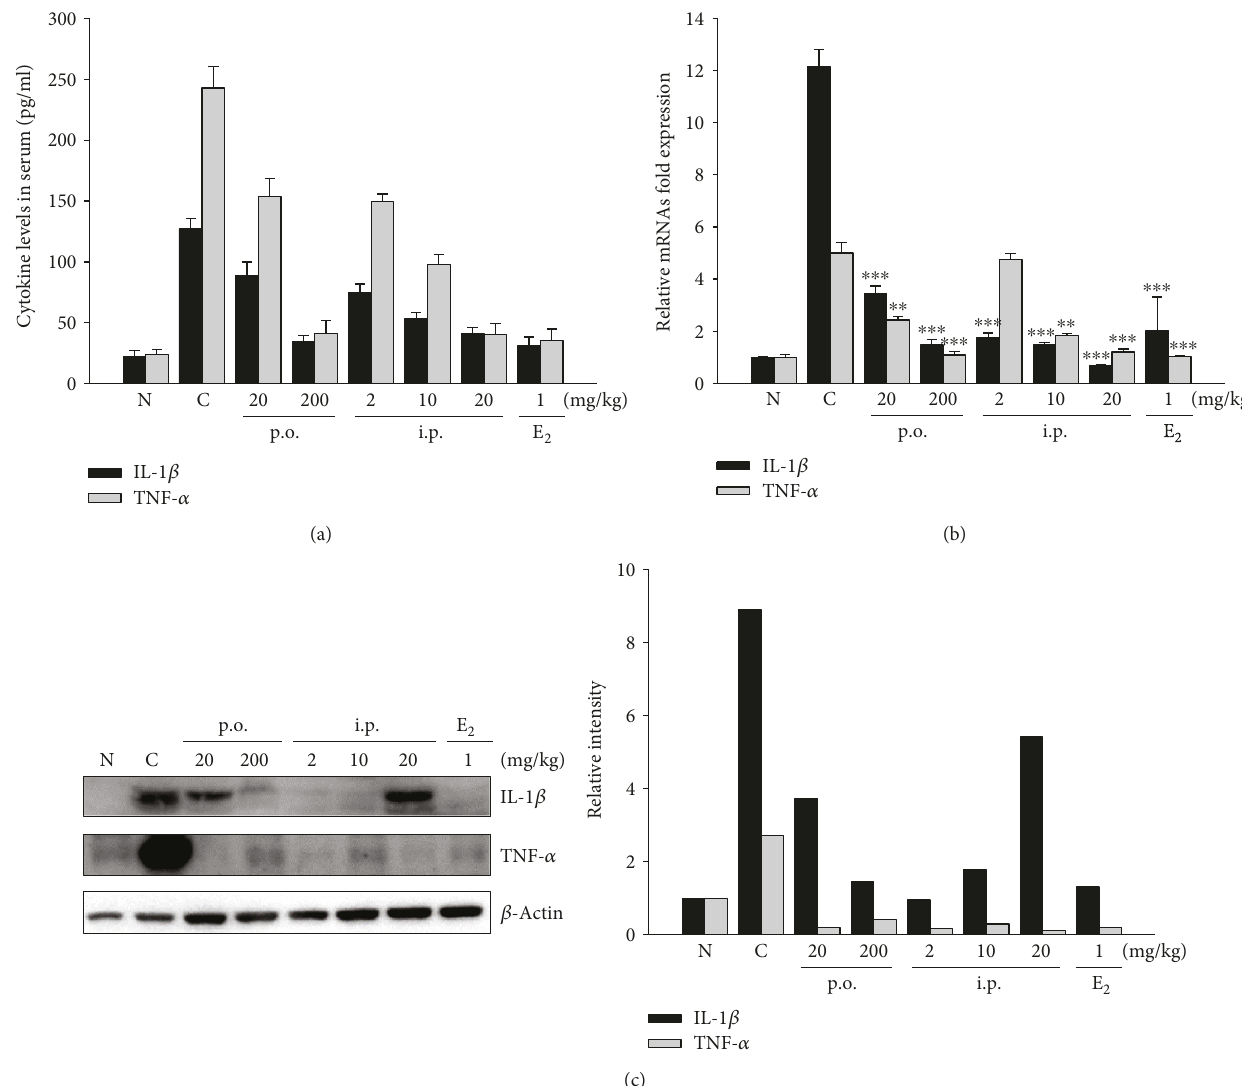
Figure 4: E ff ects of SHINBARO on proin fl ammatory cytokines in the LSS rat model. (a) Serum was collected from rats with LSS and was analyzed for IL-1 β and TNF- α levels using an ELISA kit. The data are expressed as the mean ± SD ( n = 5 ). (b) The mRNA expression of IL-1 β and TNF- α in a spinal cord tissue was determined by real-time RT-PCR. The results were normalized using β -actin as an internal control. The data are expressed as the mean ± SD ( n = 4 ). (c) The expression of proin fl ammatory cytokines in spinal cord tissues was determined by western blot analysis. β -Actin was used as an internal control. Relative intensity of indicated proteins was semiquanti fi ed using the NIH ImageJ